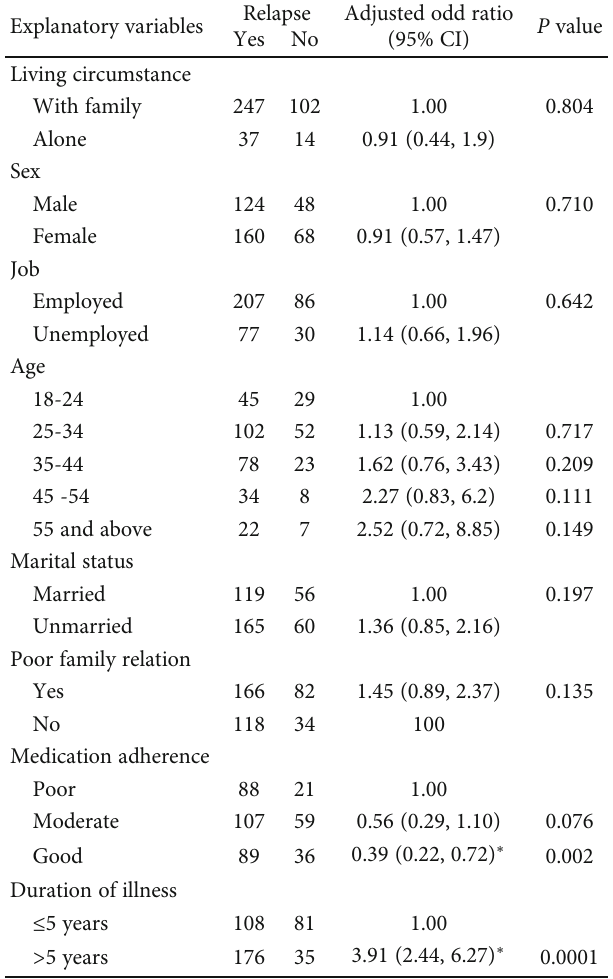
Table 3: Factors associated with relapse among patients with bipolar disorder at the Amanuel Mental Specialized Hospital psychiatric outpatient departments ( n = 400 ),